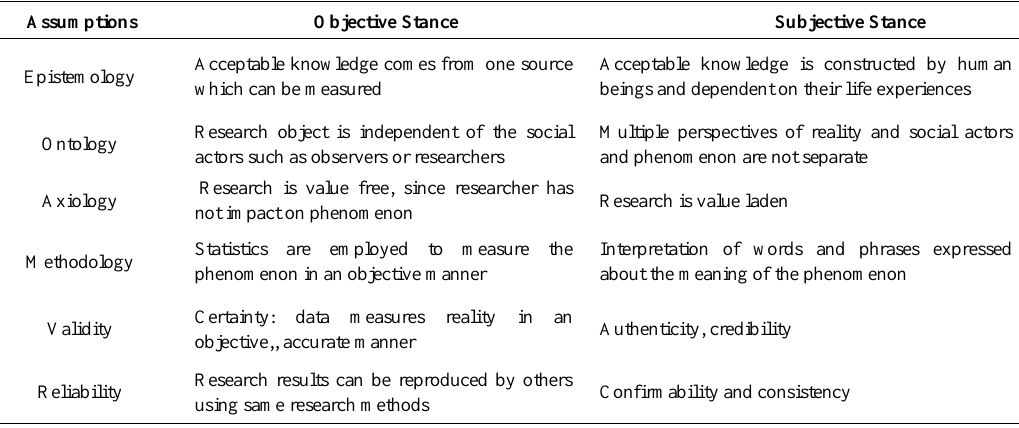
Table 1. Summary of Research Design and Philosophical Stances [6,